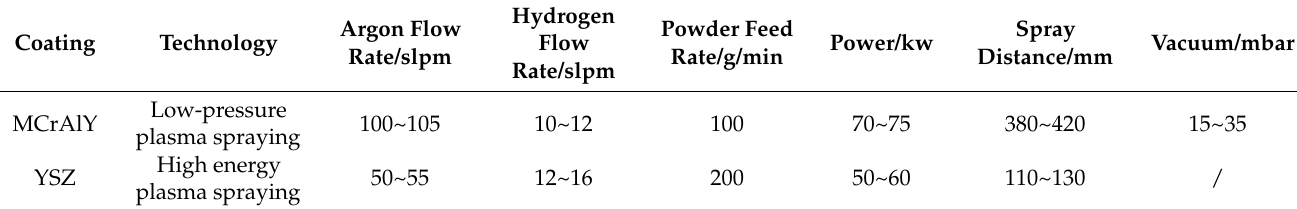
Table 1. Technological parameters of thermal spraying.